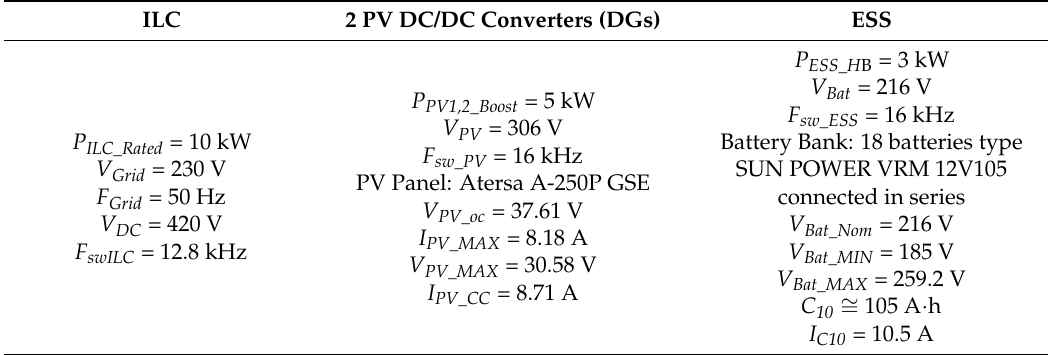
Table 2. Characteristics of the power converters of the MG.